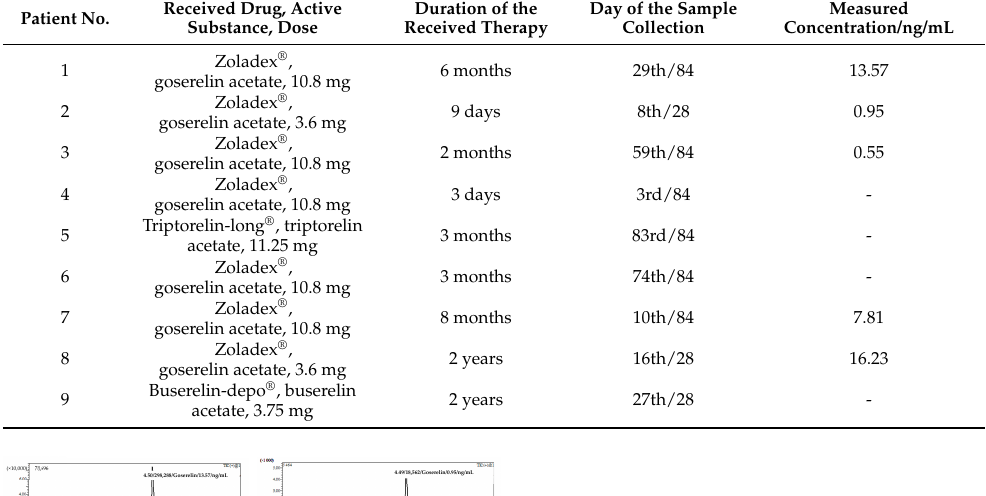
Table 4. Goserelin, buserelin, and triptorelin quantitation in patients’ blood plasma samples. Patient No.